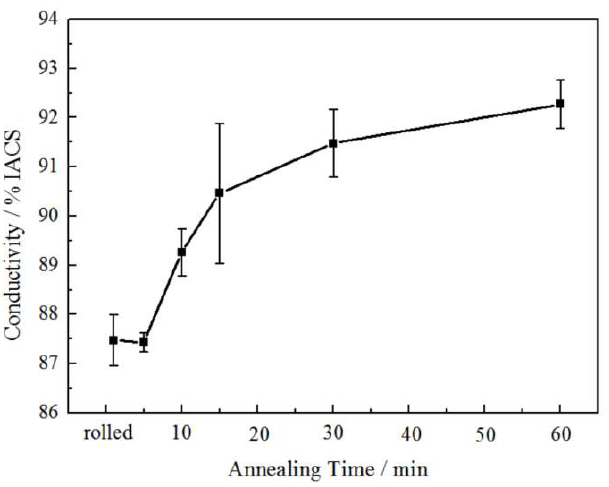
Figure 14. Influence of annealing time on the conductivity of copper foil.